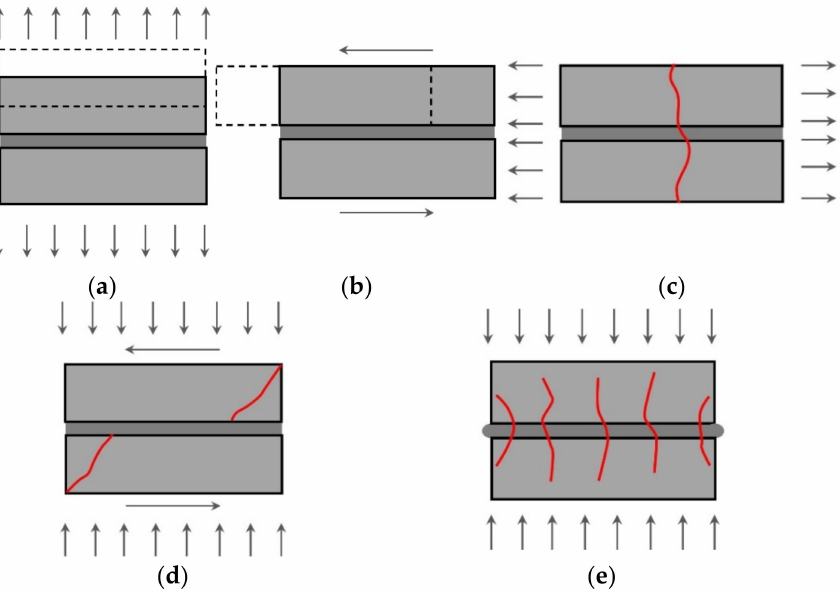
Figure 2. Masonry failure mechanisms (adapted from [27]): ( a ) joint tensile cracking; ( b ) joint slipping; ( c ) unit direct tensile cracking; ( d ) unit diagonal tensile cracking; ( e ) masonry